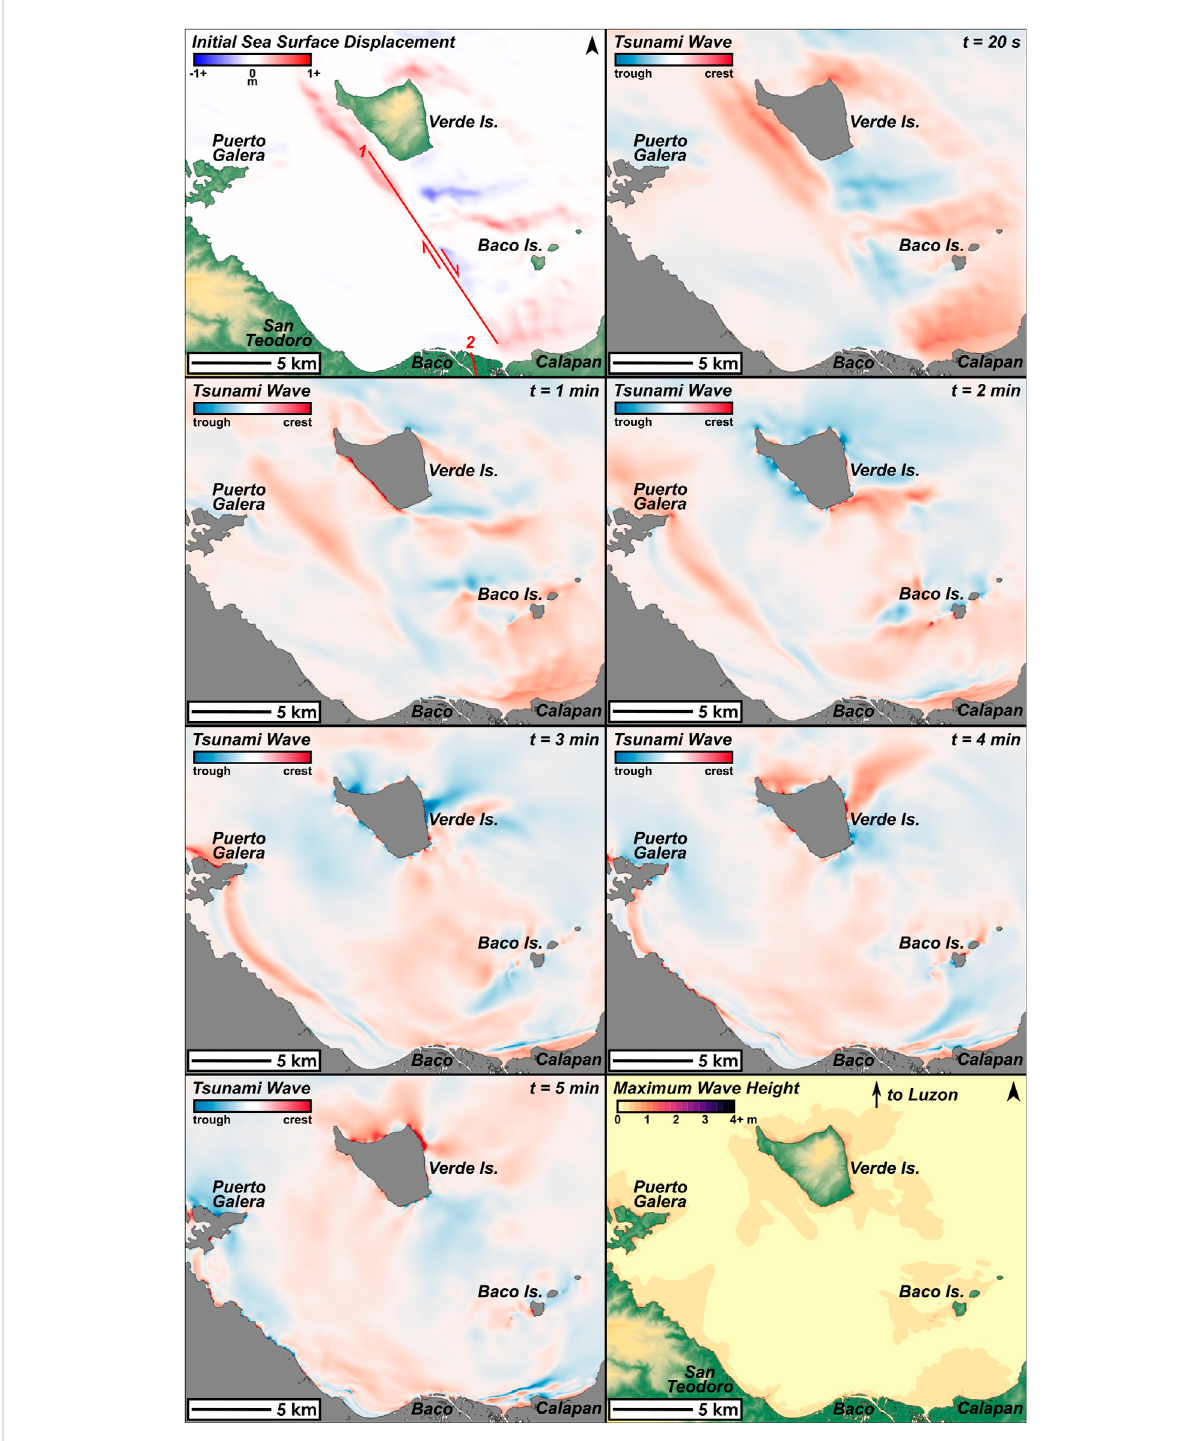
FIGURE 6 Initialseasurfacedisplacement,tsunamipropagation,andmaximumwaveheightdistributionoftheEQ-onlymodel.TheAglubangRiverFaultis shown in red, segmented into two sub-faults as described in Table